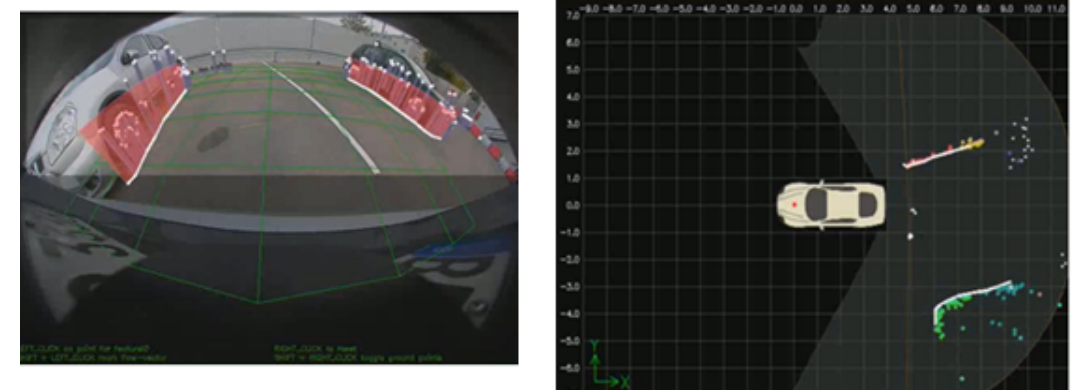
Figure 2. Reprojected and top view of 3D